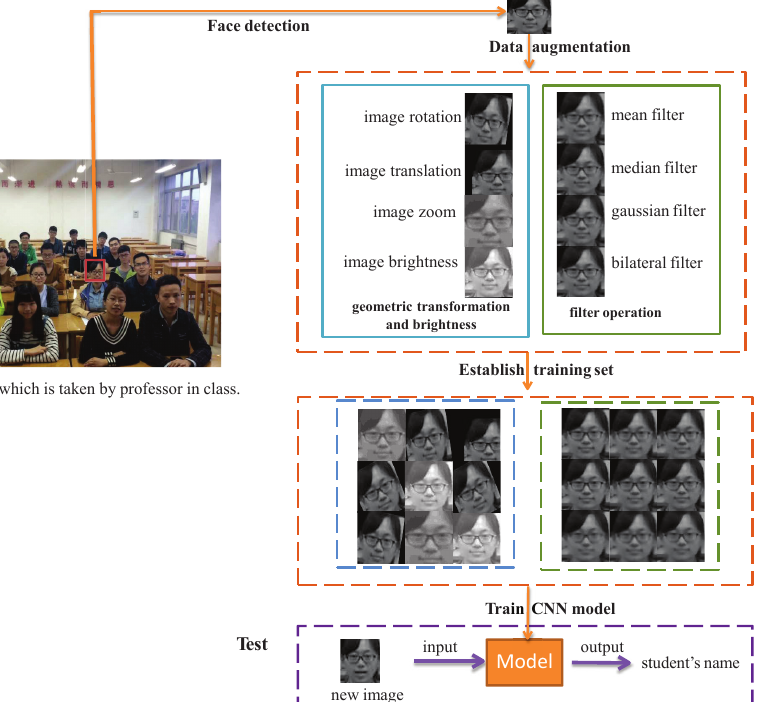
Figure 2. The workflow of our class attendance-taking method. First, the instructor takes a photo of the class with all the students’ faces. Then, face detection is used to capture each student’s face. Data augmentation is performed to increase the number of training images in the dataset. Finally, the convolutional neural network (CNN) can be trained to generate a model that can be used to predict a student’s